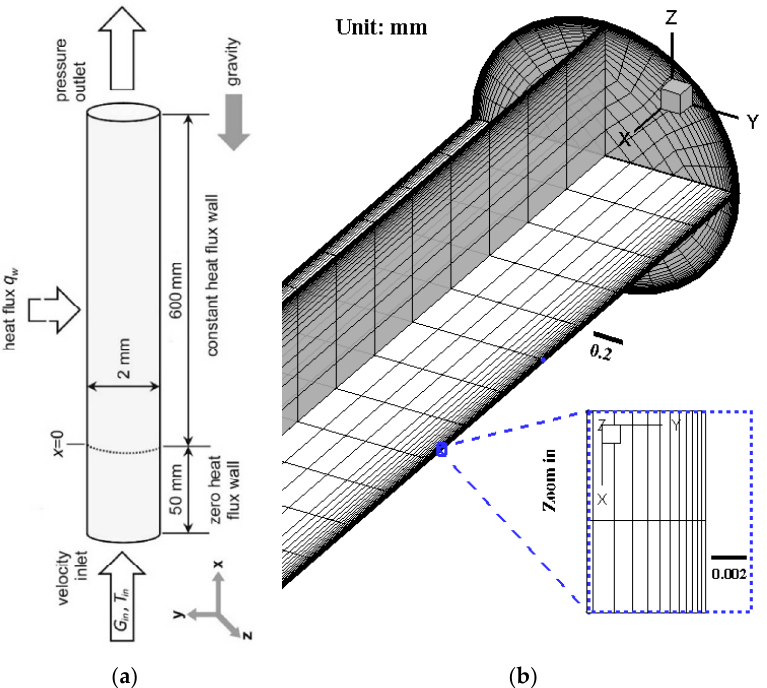
Figure 3. Physical model ( a ) and computational grids with local enlarged boundary layer ( b ). Table 2. Average wall temperature under four sets of grids.